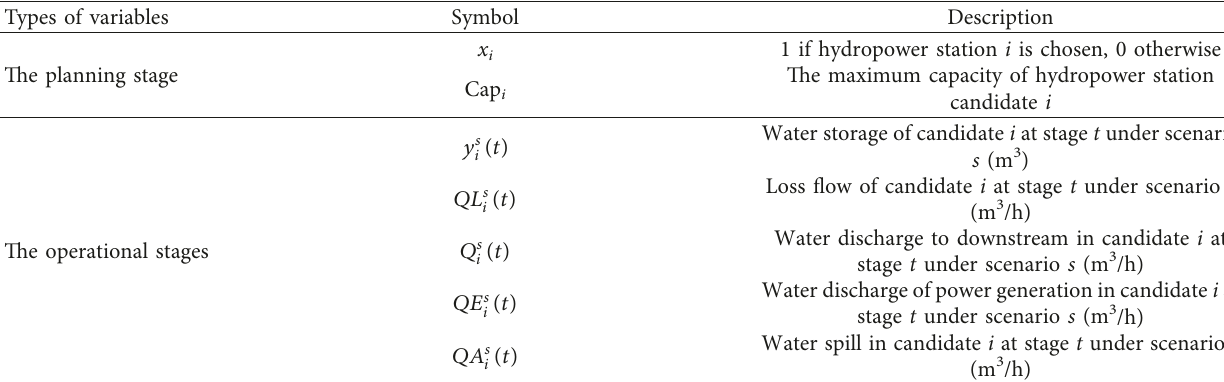
Table 2: Decision variables.